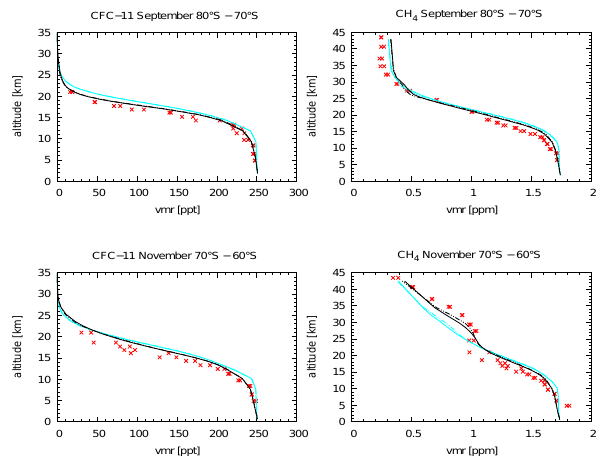
Figure 5. Profiles of CFC-11 and CH 4 for different months and lat- itude bins: ACE-FTS climatology is shown in red, blue profiles dis- play simulation results with EMAC-FFSL transport and black pro- files show results with EMAC/CLaMS full Lagrangian transport. Solid lines show mean values over 10 years of simulation, whereas dash-dotted lines indicate results for only the last 5 years of simu- lation. The profiles for the simulations have been generated as fol- lows: daily output have been interpolated onto a regular grid, then monthly mean values are calculated. The mean value of all simu- lated years for the respective latitude bins is shown here. ACE-FTS climatological profiles are shown for 72.5 and 77.5 ◦ S in the top panels, and for 62.5 and 67.5 ◦ S in the bottom panels,